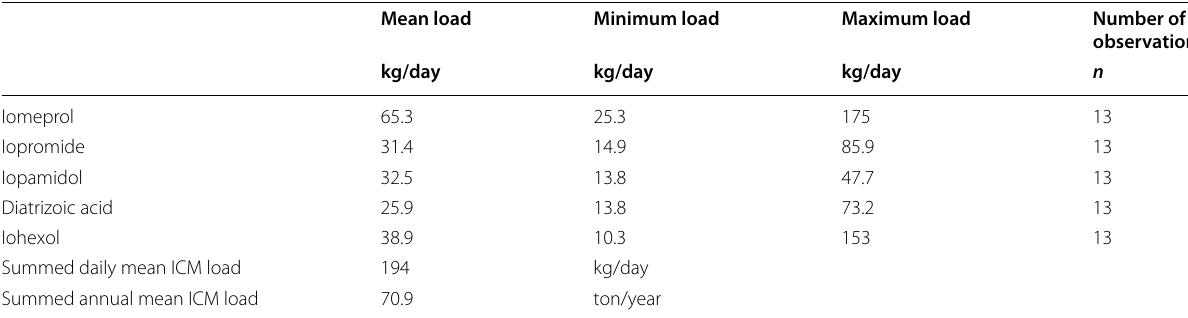
Table 1 Load of iodinated contrast media in the Rhine at Lobith in 2020